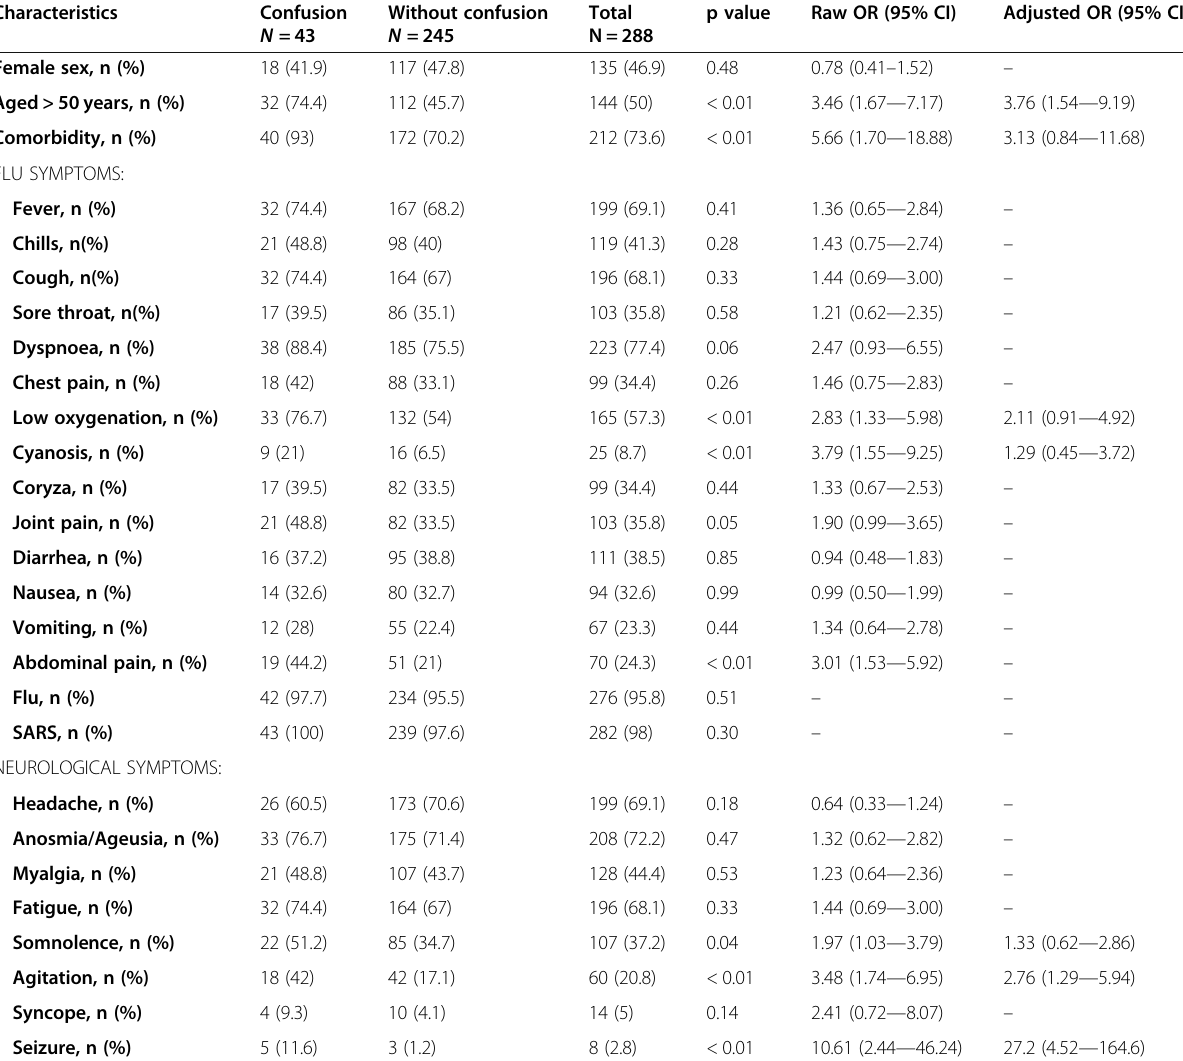
Table 3 Estimated risk for mental confusion according to patient sociodemographic and clinical characteristics